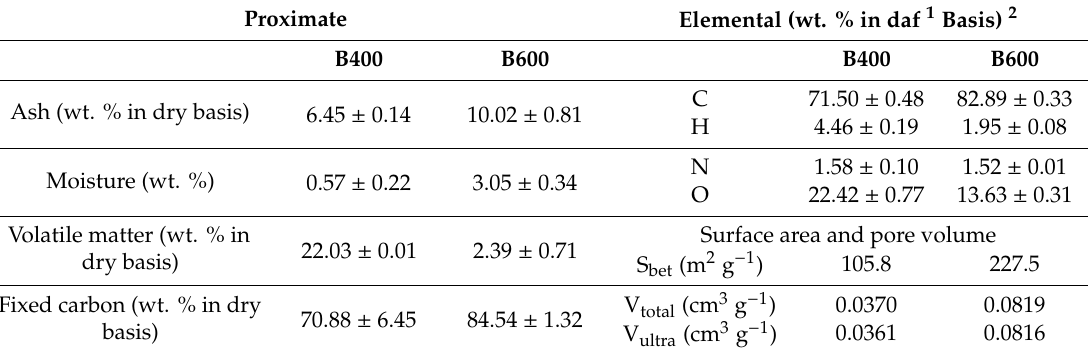
Table 1. Proximate and elemental analyses of biochar produced at two di ff erent temperatures (400 ◦ C—B400 and 600 ◦ C—B600).